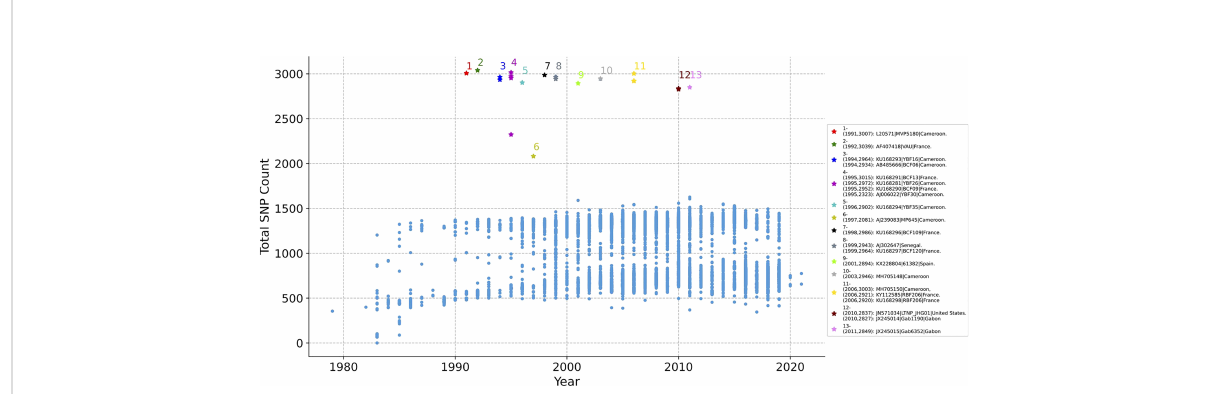
FIGURE 2 The distribution of SNP counts for each HIV-1 genome. Each genome with year label is aligned with the reference sequence of HIV-1, then the total SNP mutation of each genome is counted. Each dot represents a sequence. The total number of mutations in most sequences ranged from 500 to 1500 over time, but there are 21 genomes with abnormal mutation number, distributed in 13 years (from 1991 to 2011, marked with No. 1 to 13). No.- (Year, SNP Count): Accession Number| Patient Code|